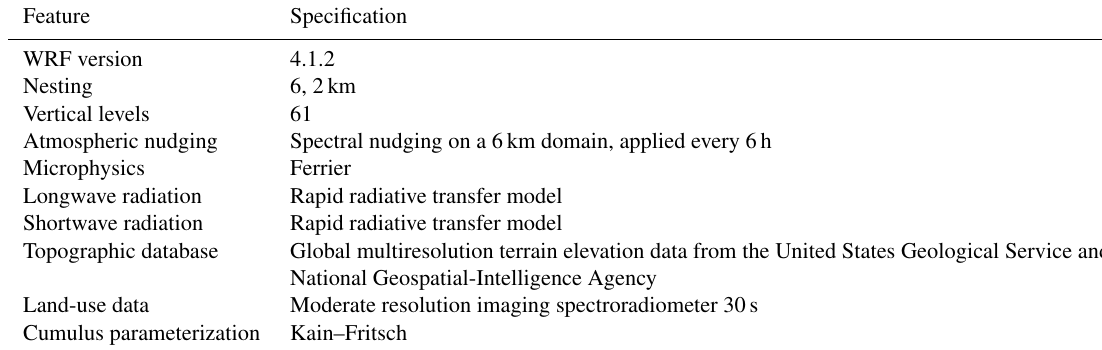
Table 1. Common specification for all of the WRF runs considered in the